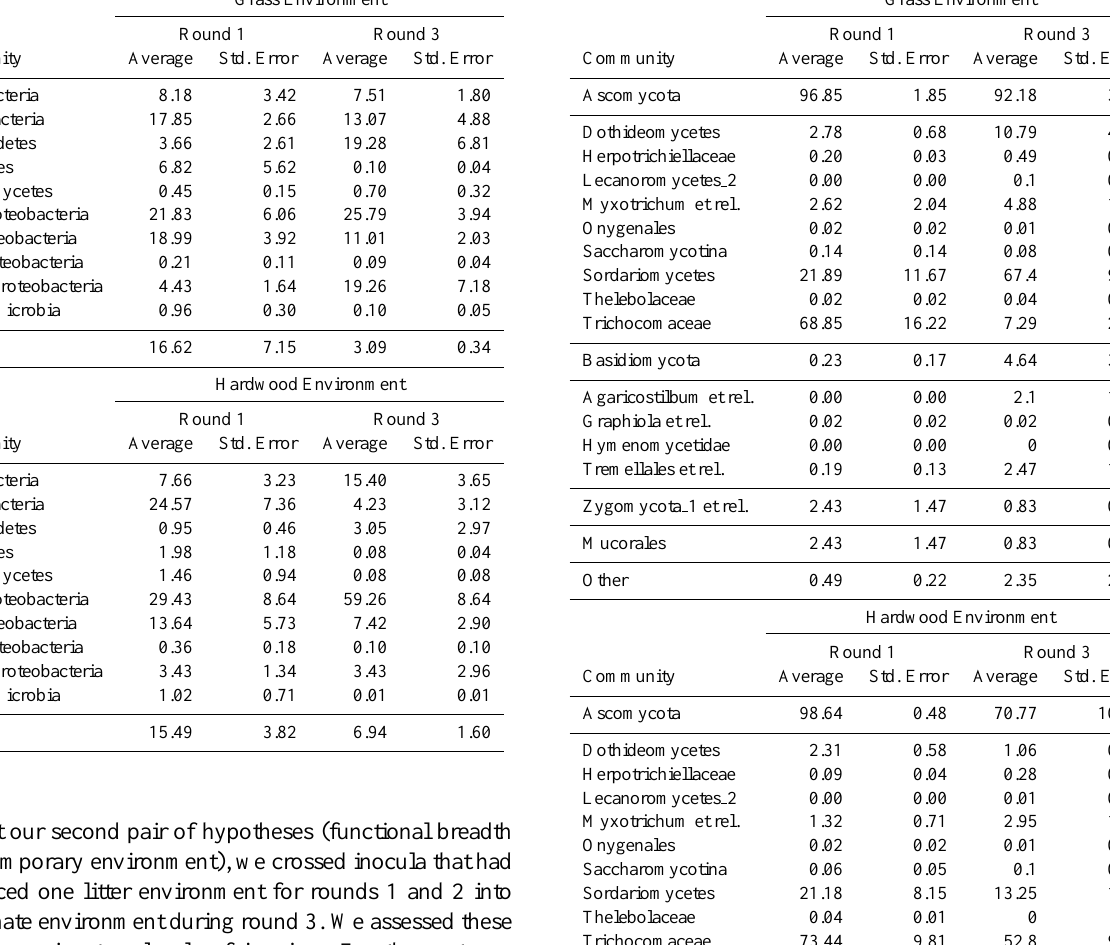
Table 2. Percent distribution of fungal taxa averaged across inocula Table 1. Percent distribution of bacterial taxa averaged across in- within a litter environment and sampling round. Each number rep- ocula within a litter environment and sampling round. Each num- resents the percent occurrence of a specific phylum or sub-phylum ber represents the percent occurrence of a specific phylum or sub- within the total number of fungal sequences. phylum within the total number of bacterial sequences. Grass Environment Round Round 1 Round 3 Community Average Std. Error Average Std. Error